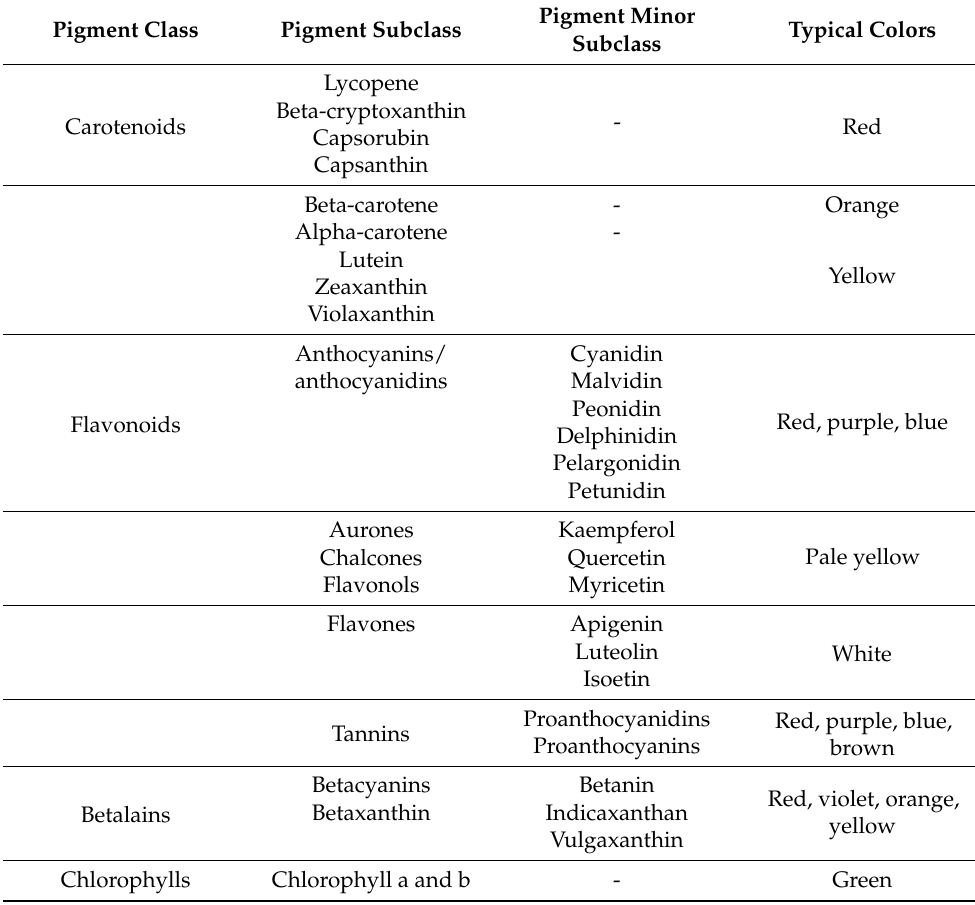
Table 1. Natural bioactive pigment classes and subclasses and the typical colors they produce in fruits and vegetables [16]. Pigment